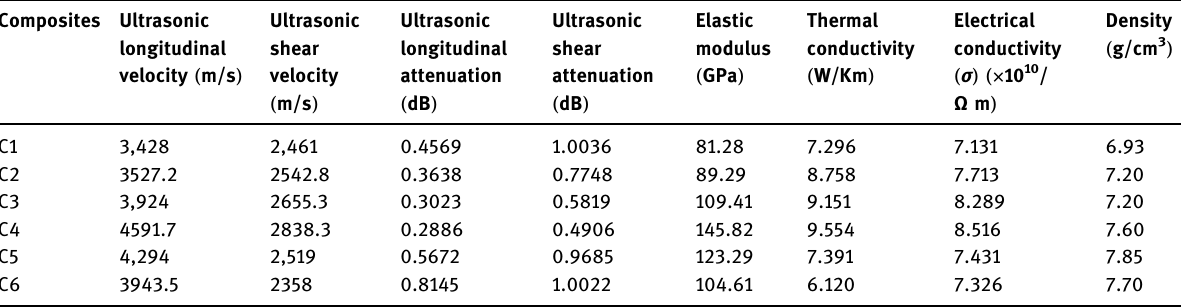
Table 2: Ultrasonic, thermal, and electrical properties of WC – Co – Ni – Cr composite samples Composites